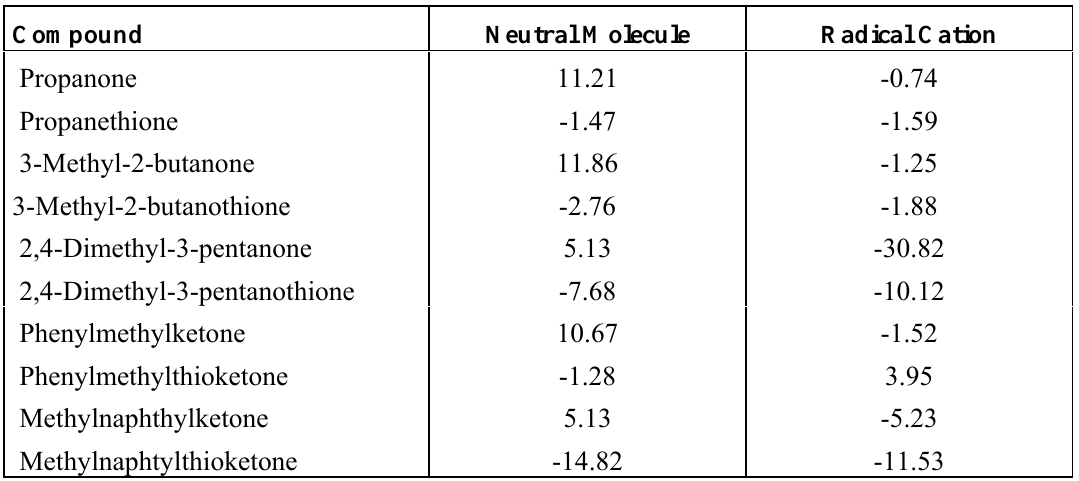
Tabla 3 . Heats of Formation Difference (kcal mol -1 ) for the Enol-Ketone and Enethiol- Thioketone Transformations by AM1